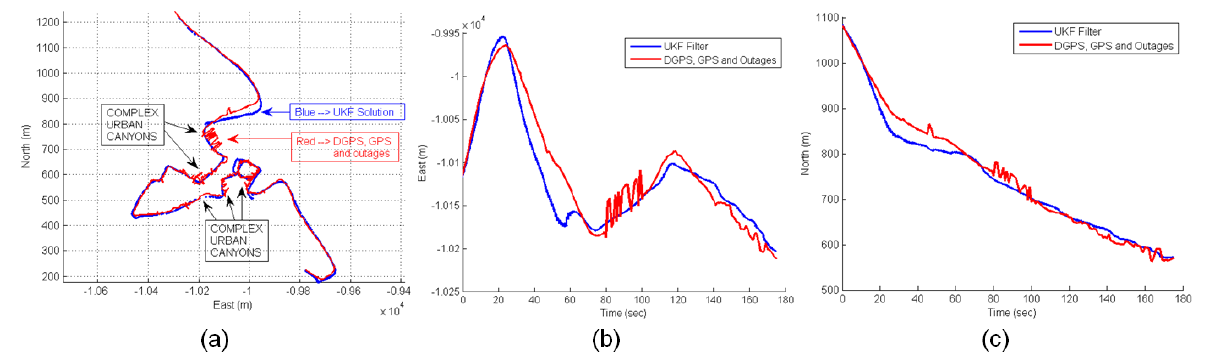
Figure 20. ( a ) Rover trajectories within complex urban canyons: DGPS, GPS and Outages (red), and UKF solution (blue) ( b ) Time-domain detail of East UKF solution. ( c ) Time-domain detail of North UKF